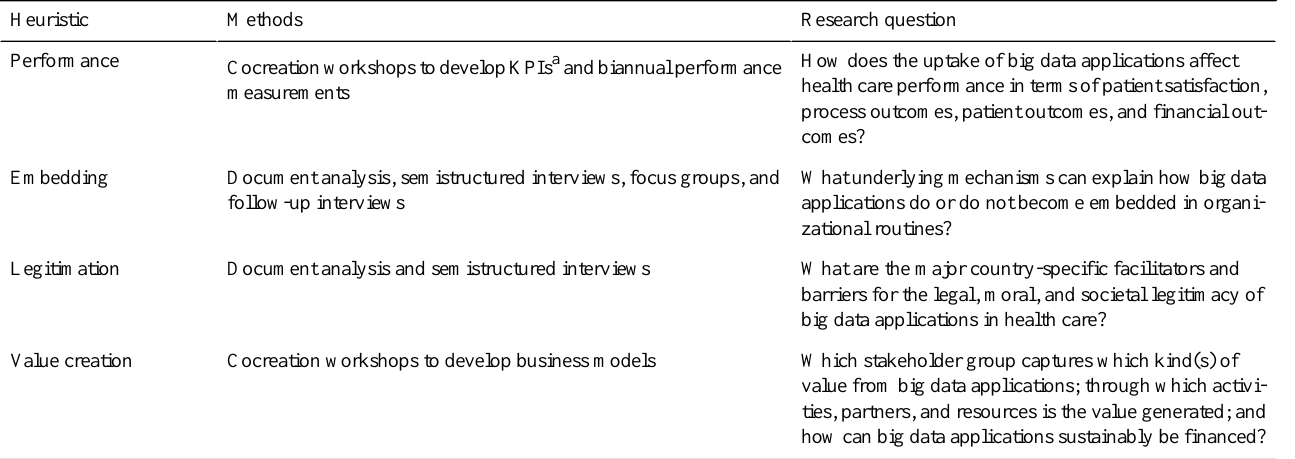
Table 1. Key concepts and